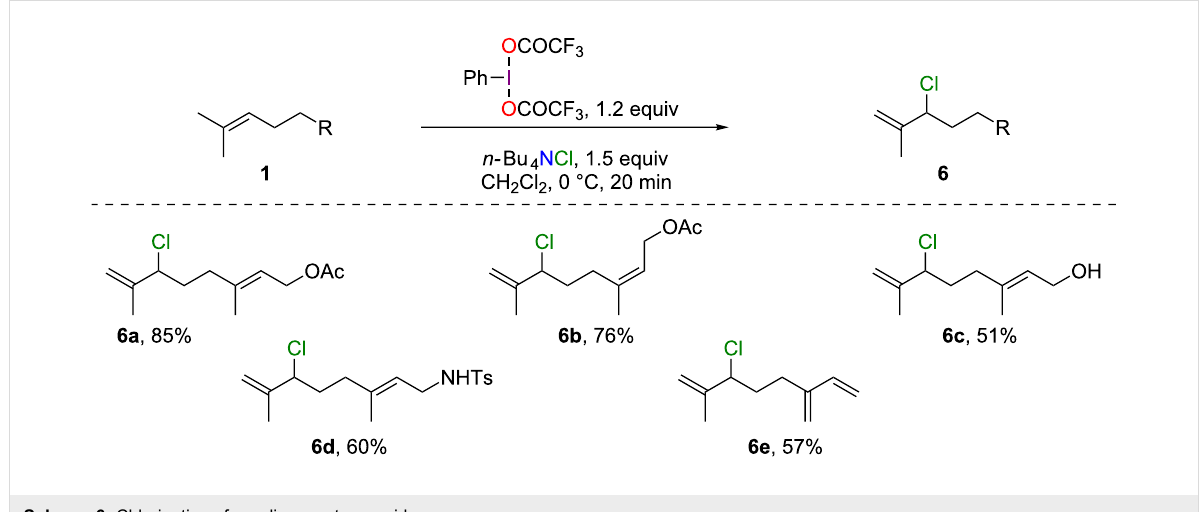
Scheme 6: Chlorination of acyclic